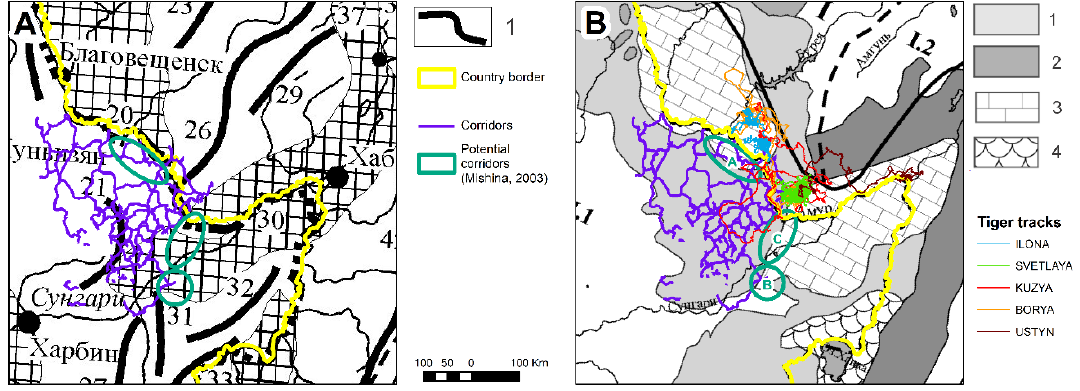
Figure A3. Combining the results and regional zoning schemes. ( A ) Orographic diagram of the basin of Amur River (Heilongjiang) [55] and potential corridors calculated using the least cost method. Symbols on the map A: 1 — mountain ranges and systems of ridges, 2 — plains. ( B ) Floristic areas of Northeast China [85] and tiger GPS tracks (lines of different colors marked with the tigers’ names Ilona, Svetlaya, Kuzya, Borya, Ustin [3]); designations on map B: 1 — Manchurian mixed forests, 2 — Ussuri broadleaved and mixed forests, 3 — Amur wetland and wet steppes, 4 — Ussuri wetlands and forest-steppes. Green circles indicate regions with potentially important green corridors of level 1.